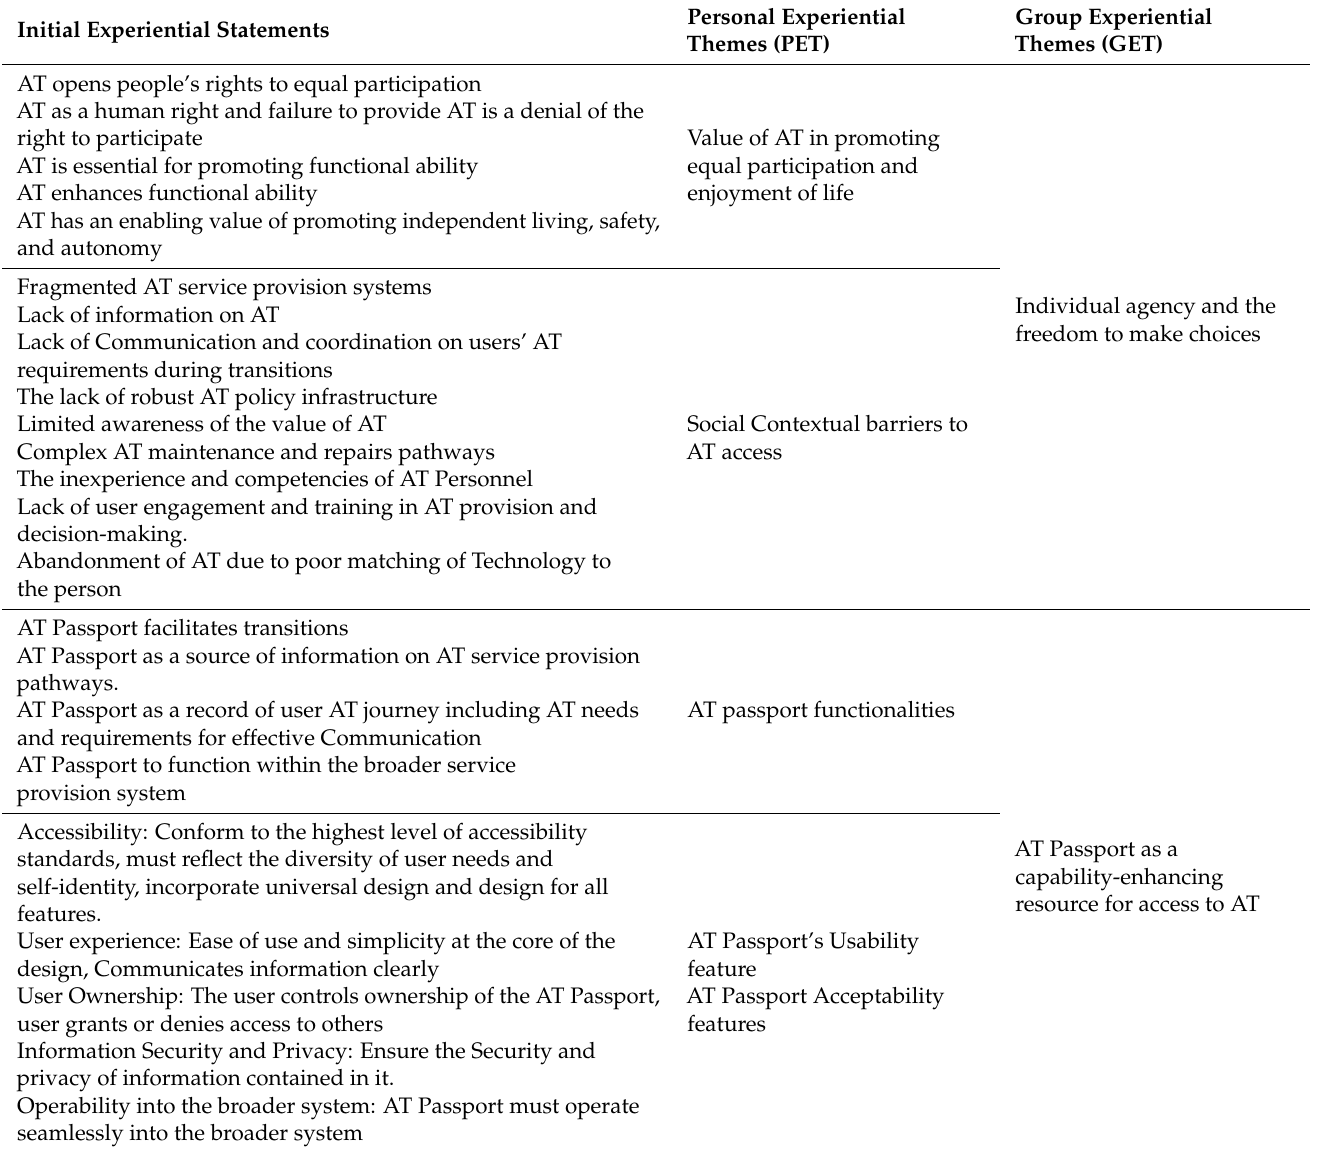
Table 2. Development of Group Experiential